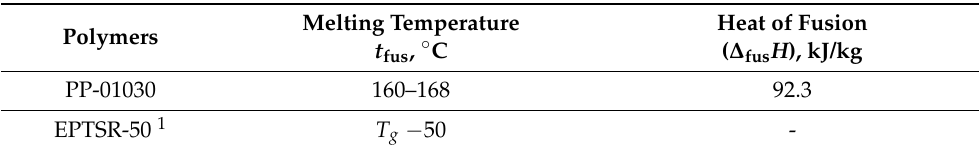
Table 1. Physical properties of polymers used in the present study.